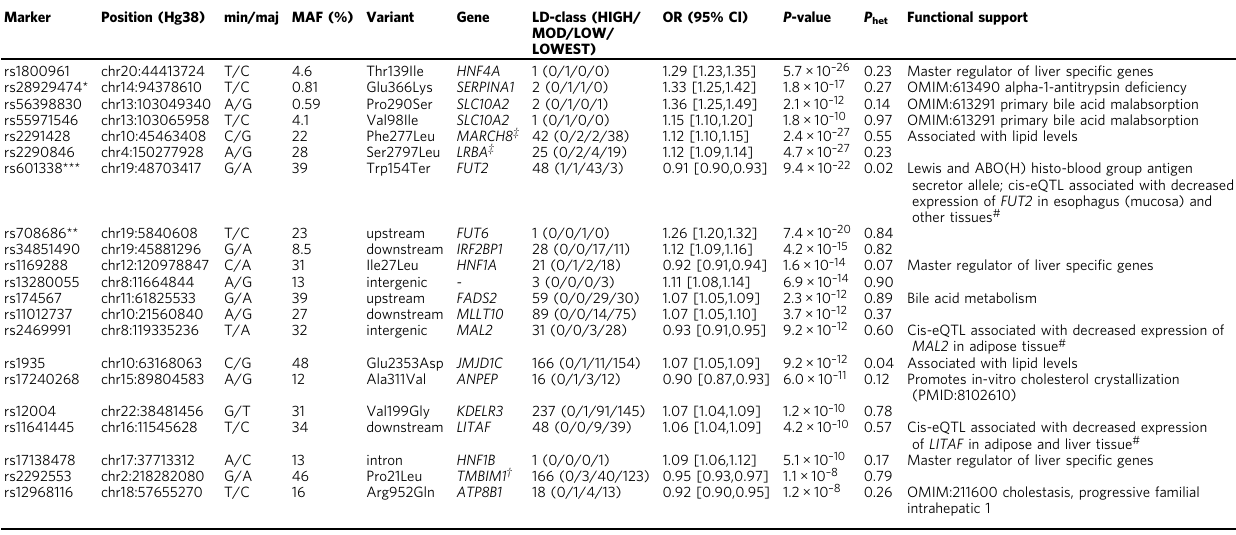
Table 1 Novel gallstone disease associated variants found in the meta-analysis of Icelandic and UK Biobank data Marker Position (Hg38) min/maj MAF (%) Variant